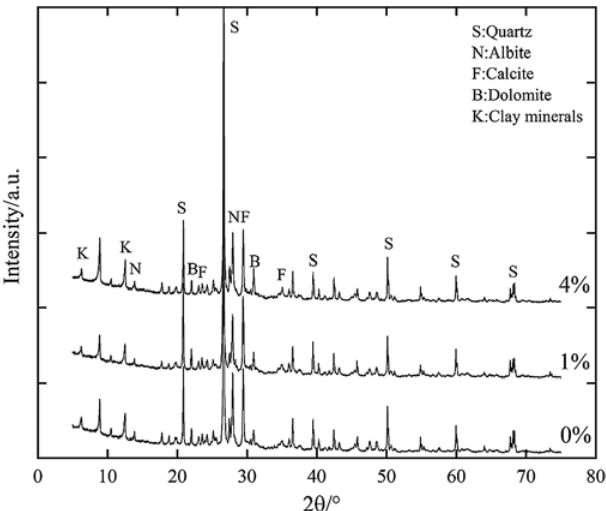
Figure 3. The XRD results of lignosulfonate-modified loess [47].